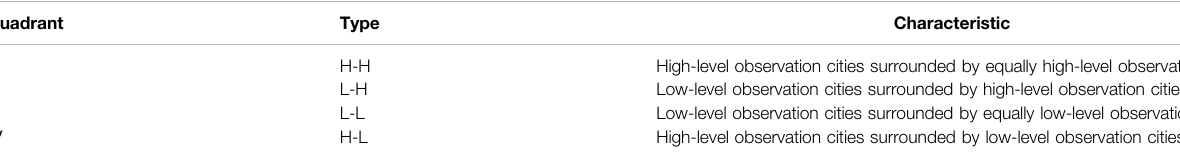
TABLE 1 | Four modes of local autocorrelation. Quadrant